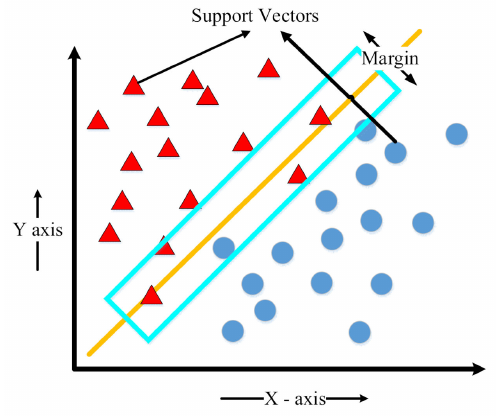
Figure 1. Binary classification based on support vector machine